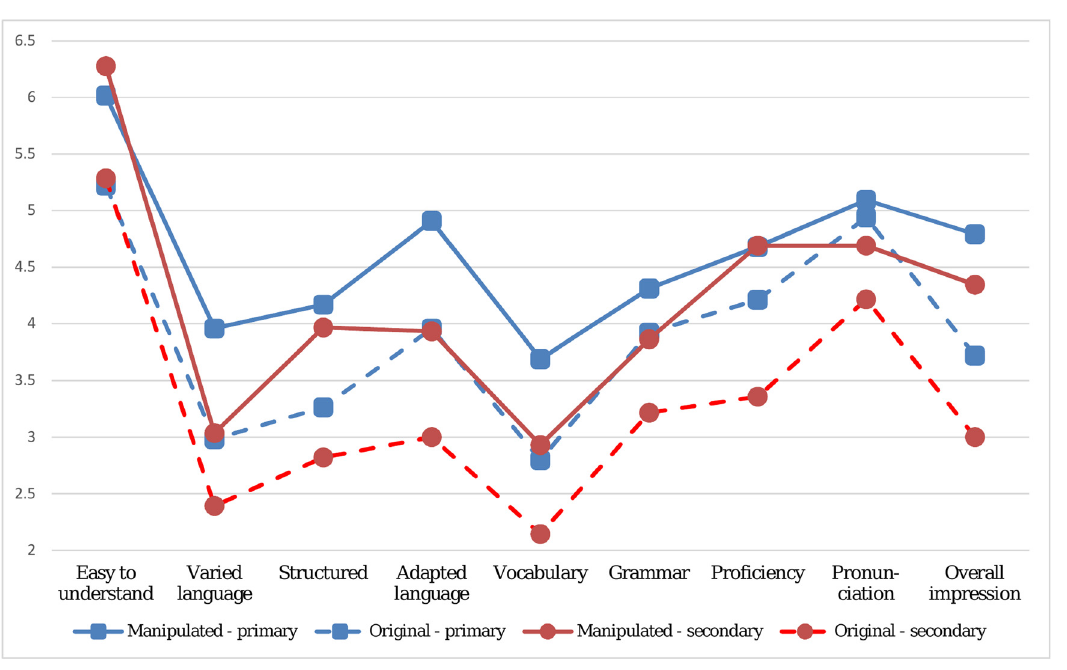
Figure 5: Di ff erences between perceptions of language performance in unmanipulated ( dotted lines ) vs the manipulated version ( solid lines ) among Swedish secondary ( red ) and primary ( blue ) teacher trainees ( n = 290 )